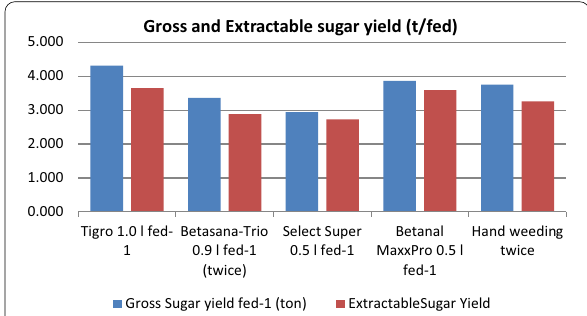
Fig.1 Effect of different weed control treatments on gross and extractable sugar yield fed − 1 (t)